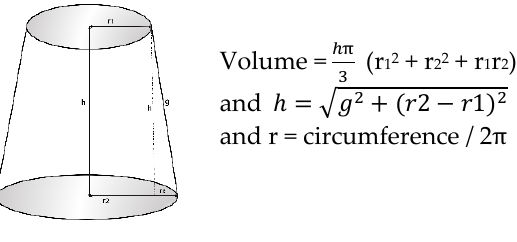
Figure 2. Basic components of a cone frustum.